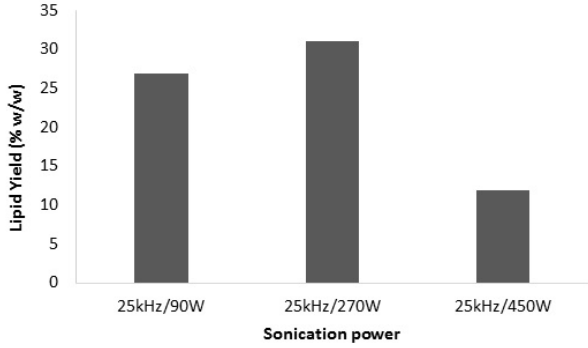
Figure 4: The yield of lipid extraction with binary solvent of n-hexane-ethanol in various ultrasonication power.